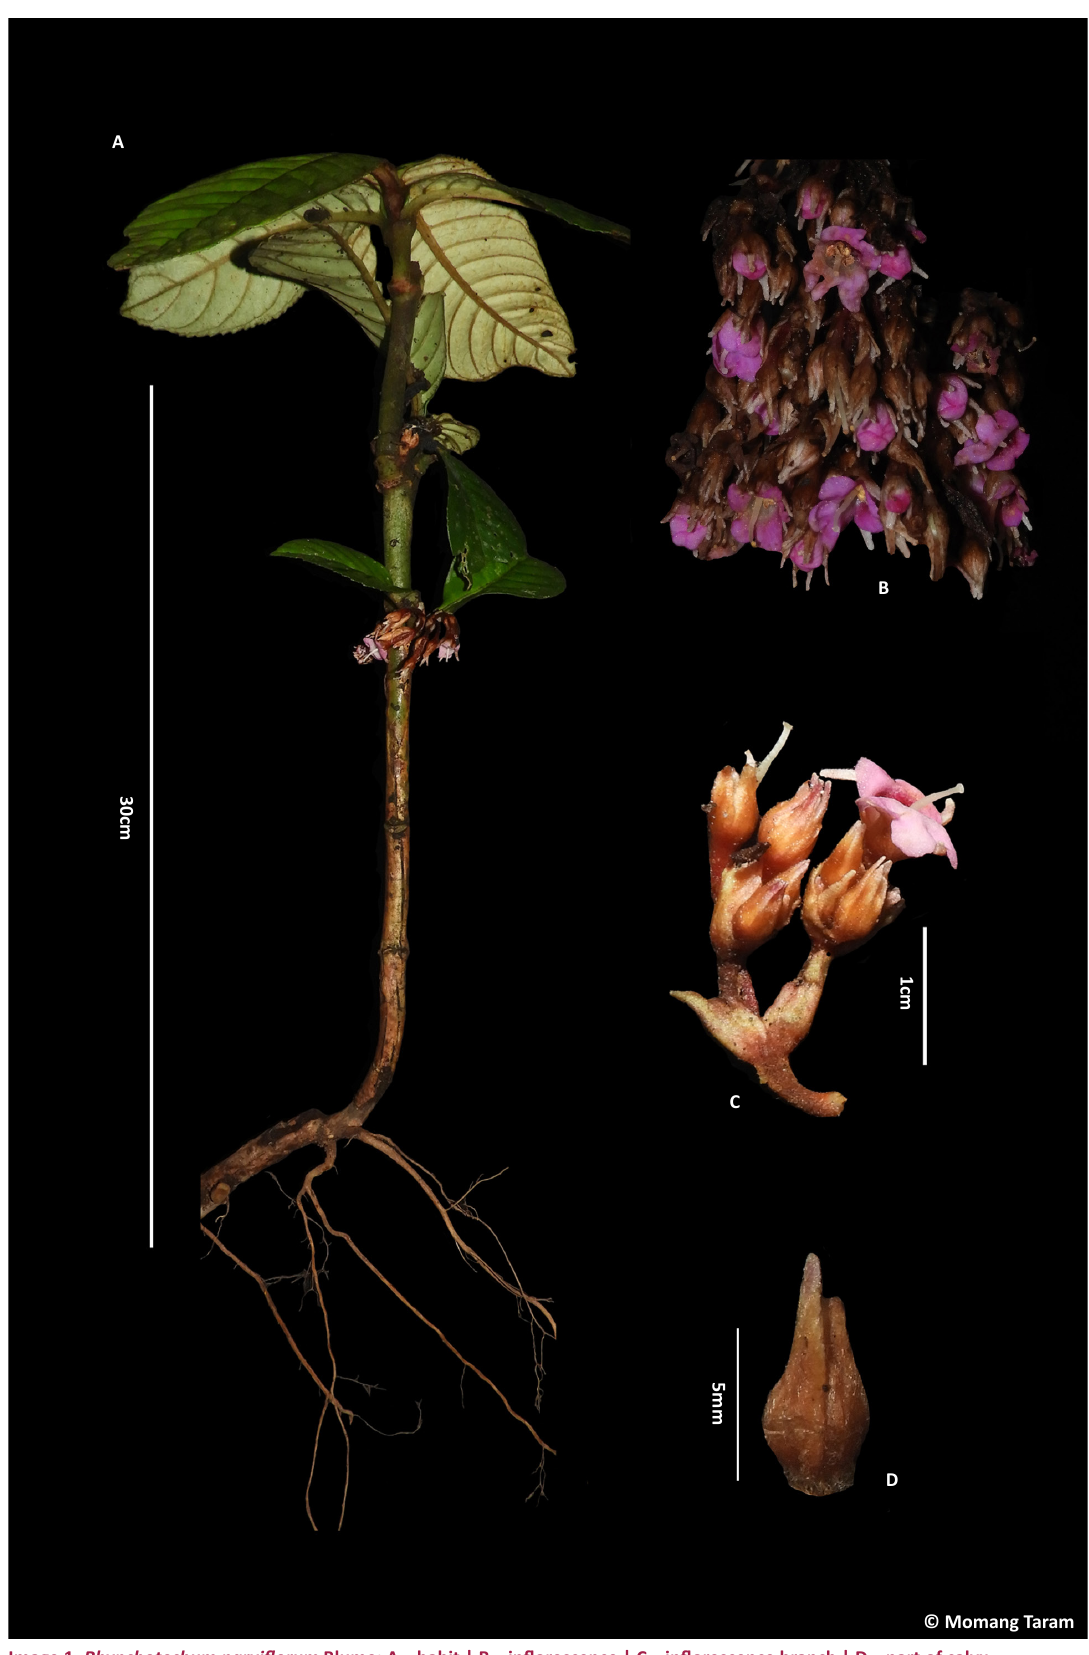
Image 1. Rhynchotechum parviflorum Blume: A—habit | B—inflorescence | C—inflorescence branch | D—part of